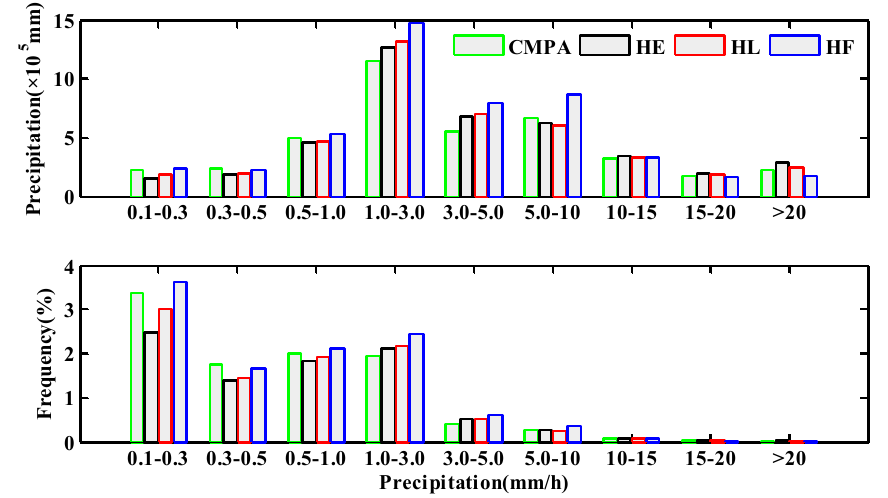
Figure 6. The cumulative precipitation and frequency of various precipitation intensities from the IMERG-HE, IMERG-HL, and IMERG-HF products, and CMPA data over the Sichuan Basin during 2016 to 2018.